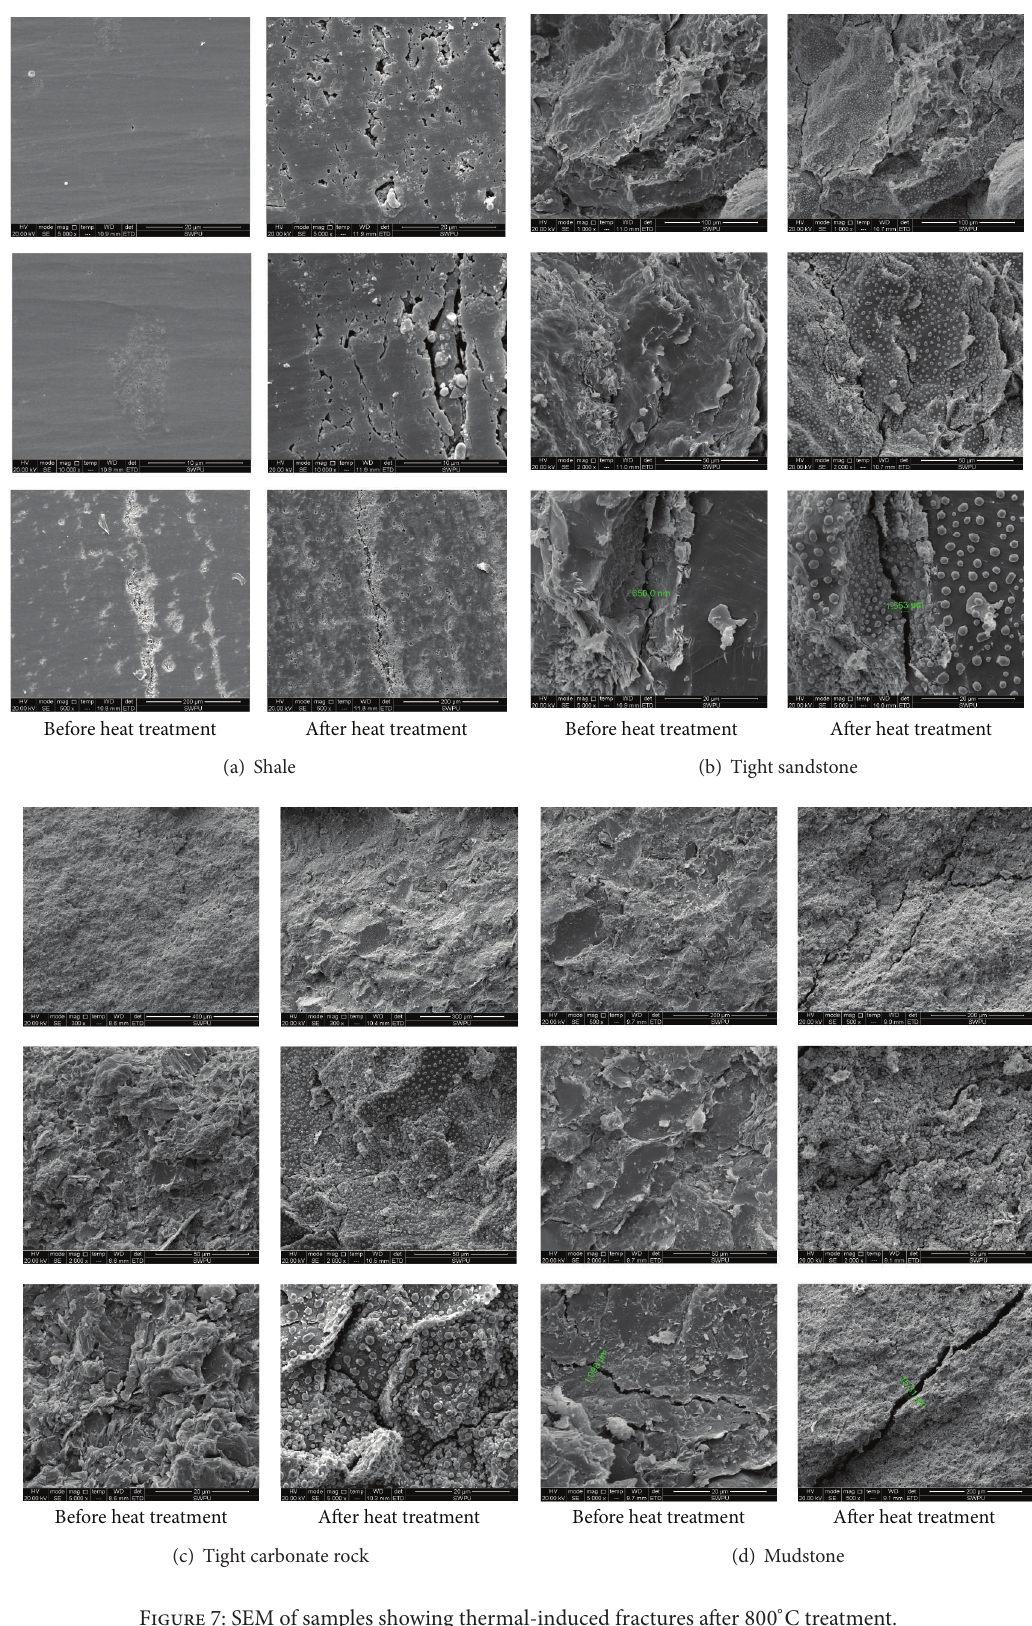
Figure 7: SEM of samples showing thermal-induced fractures after 800 ∘ C